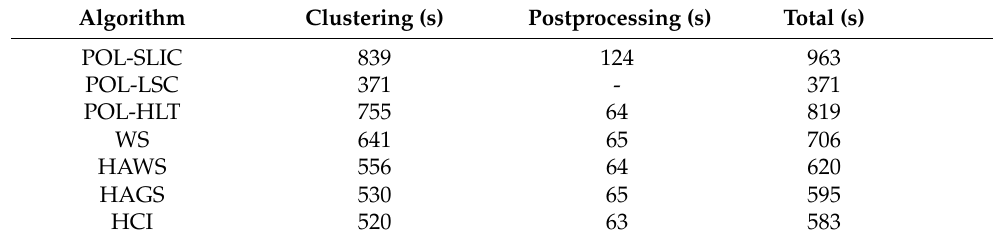
Table 2. RT(s) of the AIRSAR data set.